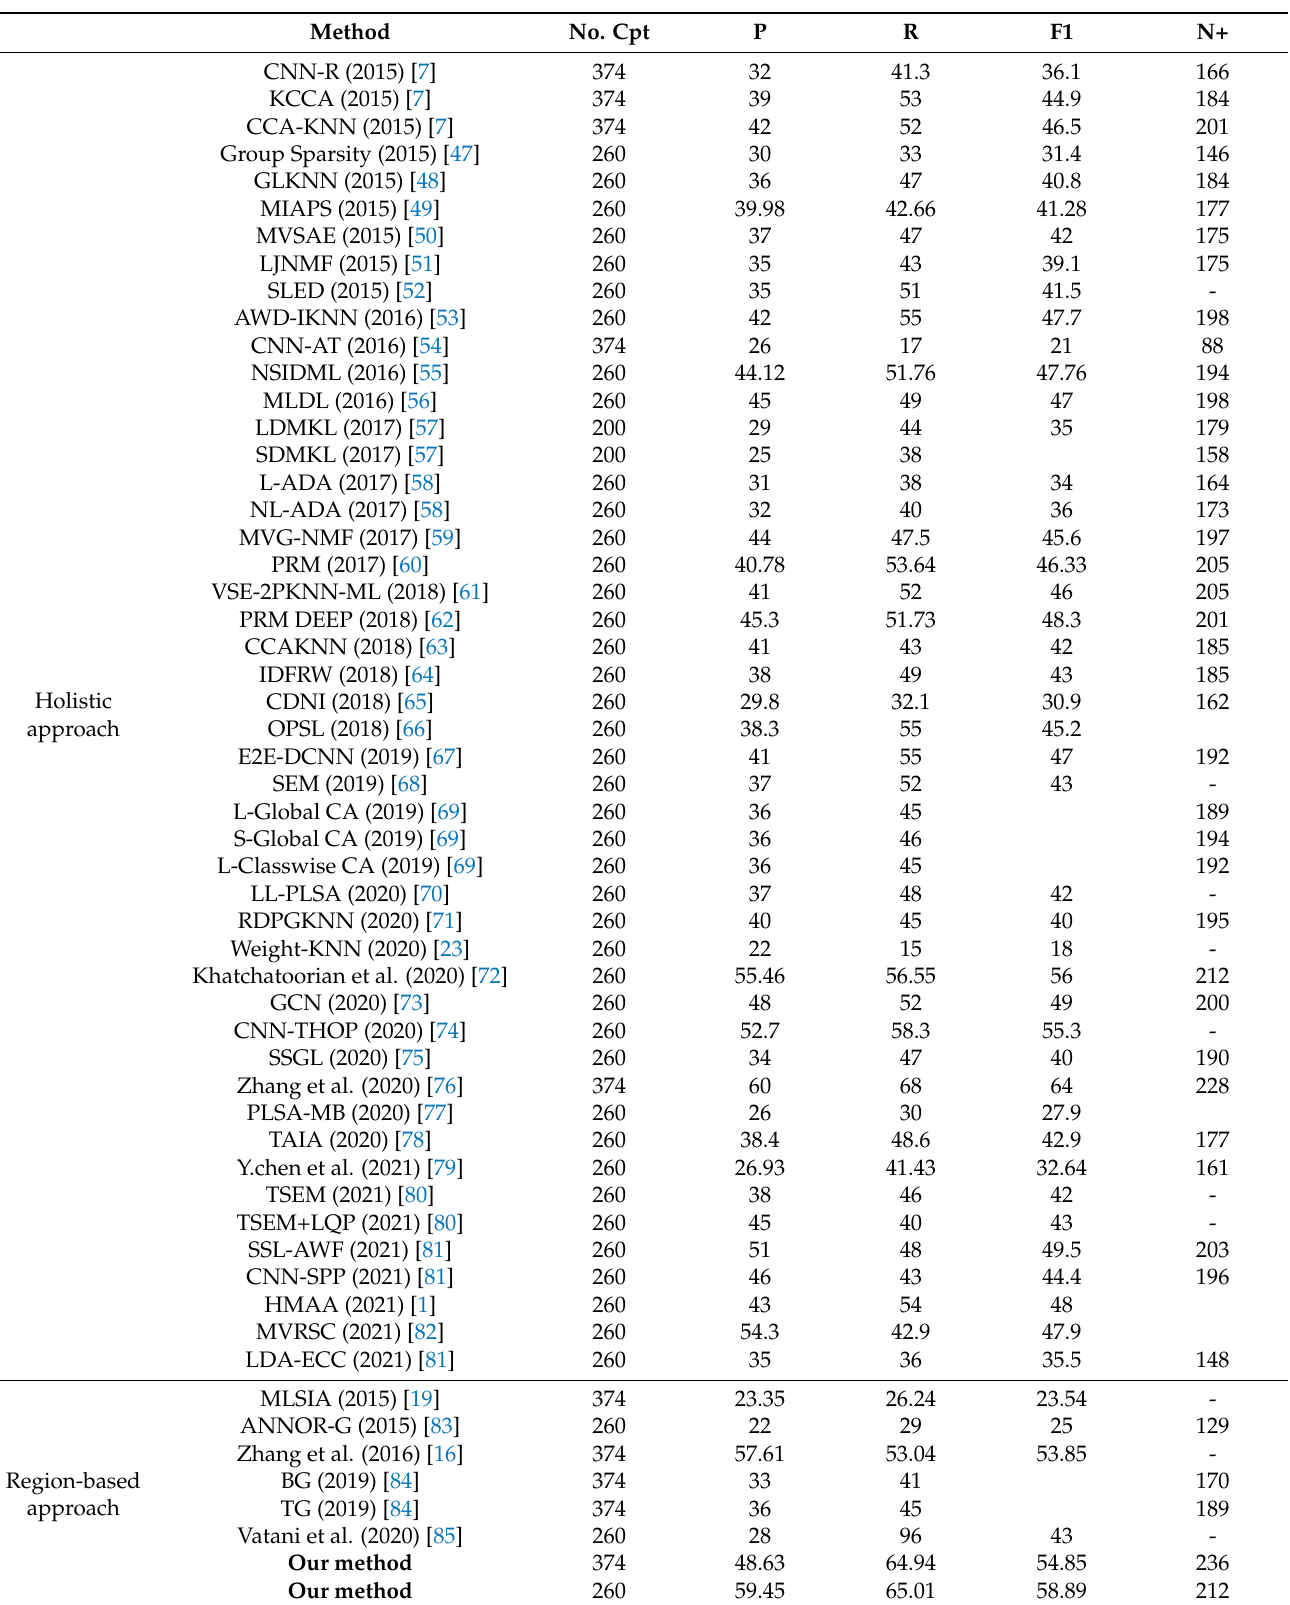
Table 2. A comparison between our method and other recent related works in terms of precision (P), recall (R), F1, and N+. The involved works adopt one of the following scenarios: considering 260 concepts or considering 374 concepts, as shown in the ‘No. Cpt’